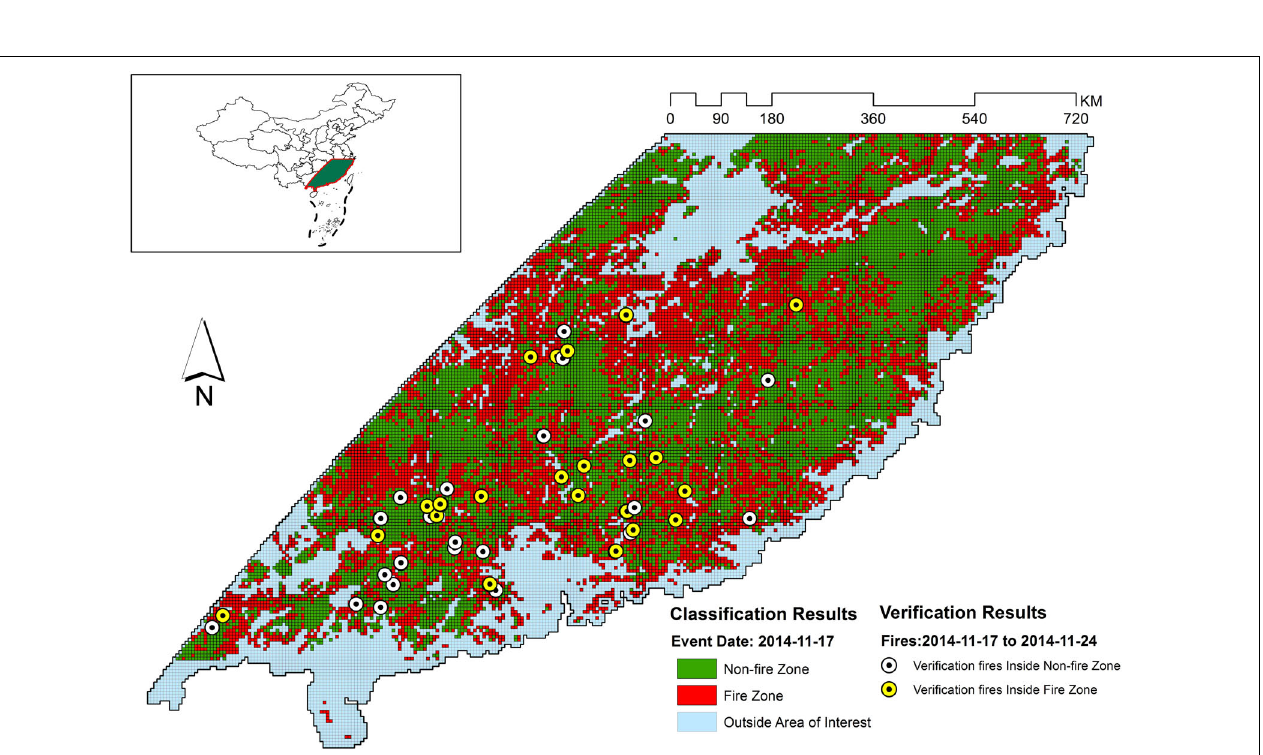
FIGURE 10 | Classification and verification results for